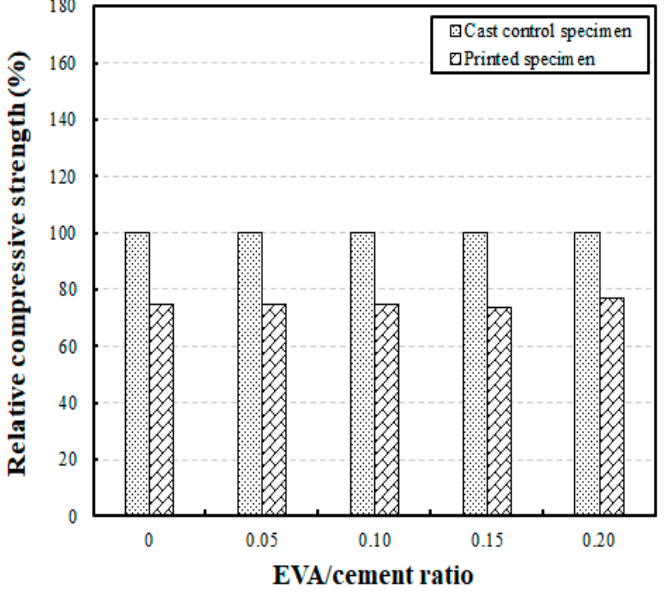
Figure 6. Comparison of relative compressive strengths of cast and printed specimens with di ff erent EVA / cement ratios.